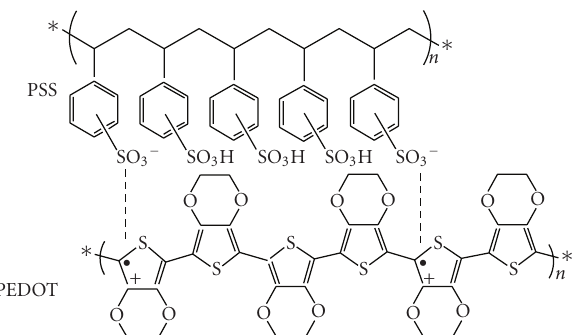
Figure 1: Chemical structure of PEDOT:PSS. The “dot” and “plus” represent the unpaired electron and positive charge on the PEDOT chain, respectively.